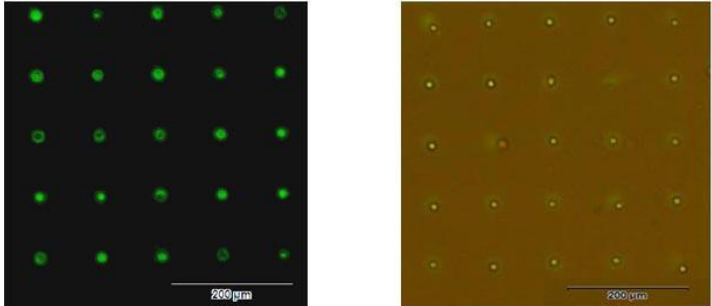
Figure 11. Single cell patterning results of HL-60 cells. Left: The fluorescence image after the patterning of antibodies. Right: HL-60 patterning results (the photo under both the bright field and the fluorescence excitation).